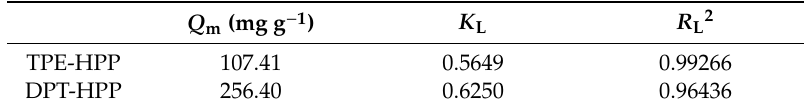
Figure 9. ( A ) Langmuir isothermal models and ( B ) adsorption isothermal curves for the adsorption of the RhB on TPE-HPP and DPT-HPP. the RhB on TPE-HPP and DPT-HPP. Table 2. Fitted parameters for the adsorption of RhB on the hypercrosslinked polymers TPE-HPP and